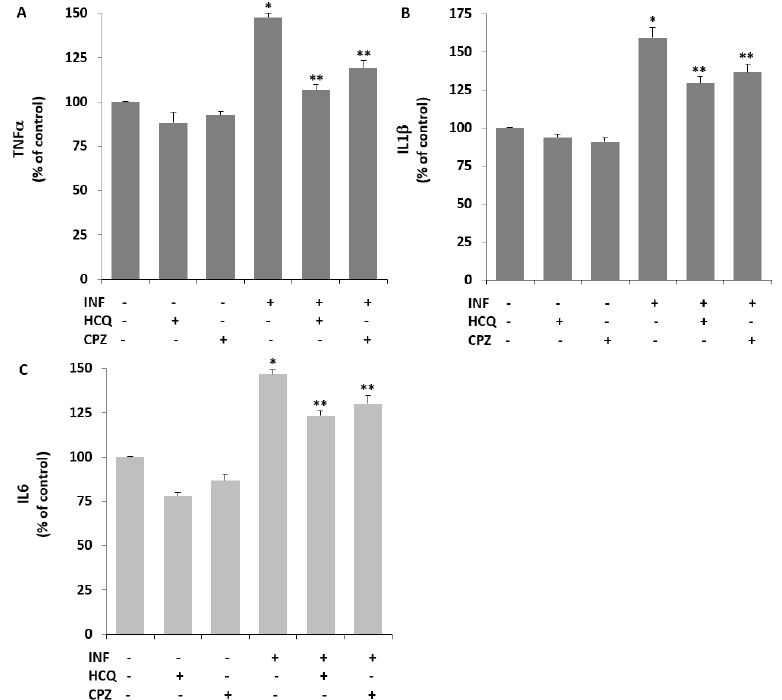
Figure 7. The acute INF-induced increases of cytokine generations were decreased in the U937 monocytes by the treatment of HCQ and CPZ. (Mean ± SD and n = 6). The generations of TNF-α ( A ), IL-1 β ( B ), and IL-6 ( C ) were assayed in the Infinite PRO 200 by using the commercial ELISA kits. * p ≤ 0.05 vs. Cntr, HCQ, and CPZ. ** p ≤ 0.05 vs.